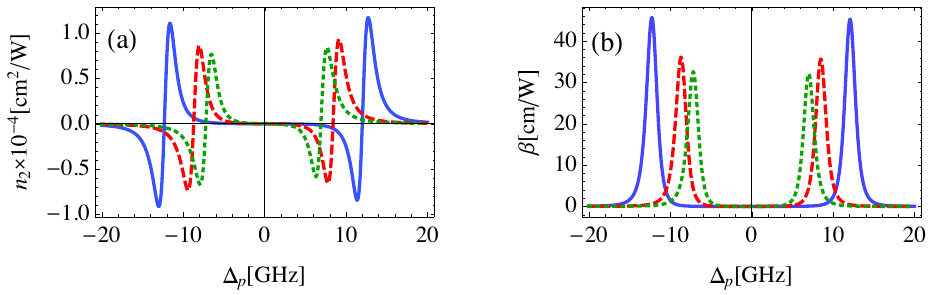
Figure 6. The self-Kerr nonlinear index of refraction ( a ) and nonlinear absorption coefficient ( b ) in the MNP-GND-QD hybrid system of R QG = 12 nm, R GM = 26 nm, θ M = 0.5 rad, θ G = 1 rad, R M = 18 nm (solid), R M = 16 nm (dashed) and R M = 15 nm (dotted), The system is excited with resonant control field of Ω c = 50